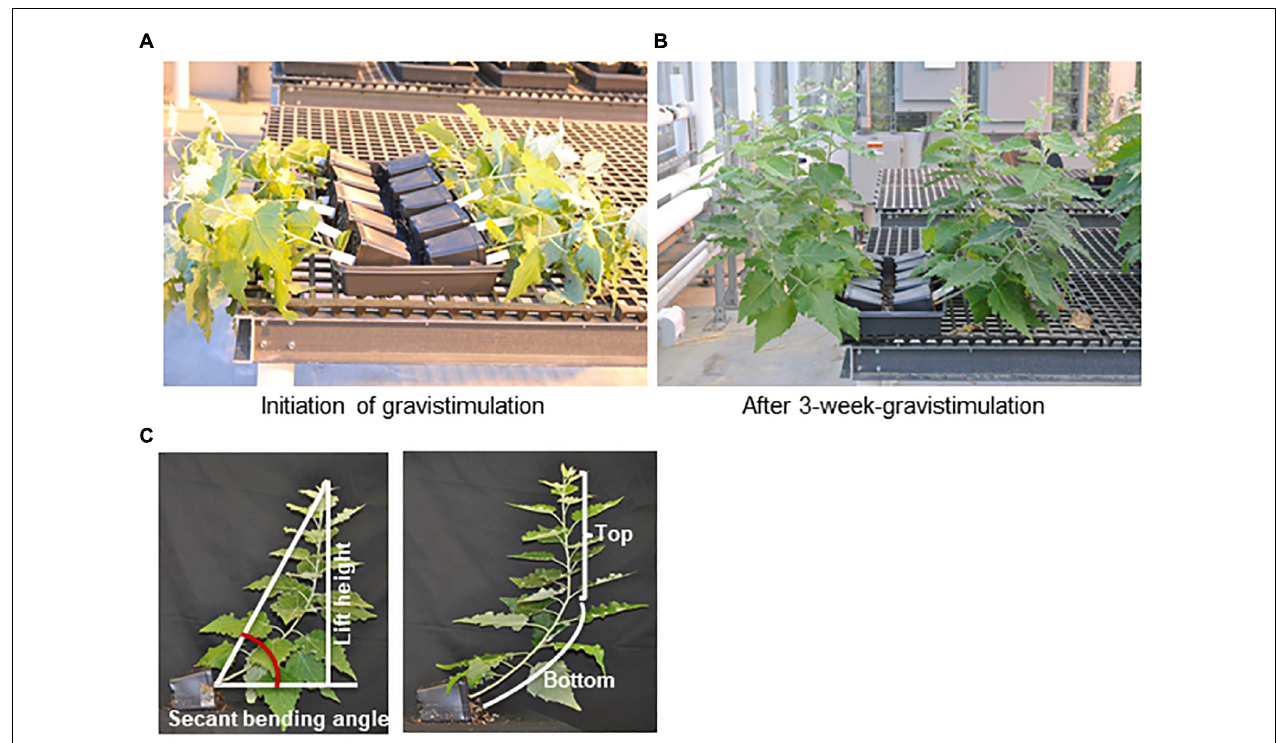
FIGURE 1 | Tension wood induction by gravistimulation. Two-month-old poplar plantlets grown in the greenhouse were laid on the trays for 3 weeks, approximately 80 degrees relative to the vertical position. (A) Poplar plantlets of the WT, phbmt1 mutants, and PHBMT1 -overexpression (OE) lines at the initial point of gravistimulation trial. (B) Poplar plantlets of the WT, phbmt1 mutants, and PHBMT1 -OE lines at the end point of 3-week gravistimulation. From far to near are the WT, phbmt1 mutants g1-8 and g1-9, and overexpression lines OE1 and OE2, respectively. (C) Illustration of definition of the top stem, bottom stem, stem lift height and the stem secant binding angle of poplar plantlet with gravitropic